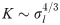
The turbulent pair diffusivity against separation, as log(K) against log(l).The symbols are the observational data reported by Richardson in 1926 (Table 1). The red filled circle (N1) is from of the molecular diffusion of oxygen into nitrogen. The black filled circles (N2-N7) are from geophysical settings. The dotted blue line is Richardson’s assumed locality scaling, K∼σl4/3. The solid red line is the least square line of best fit to the entire 1926 dataset (N1-N7), K∼σl1.248. The solid black line is the least square line of best fit to the revised dataset (N2-N7), K∼σl1.564, and the coefficient of determination is, R2 = 0.97.